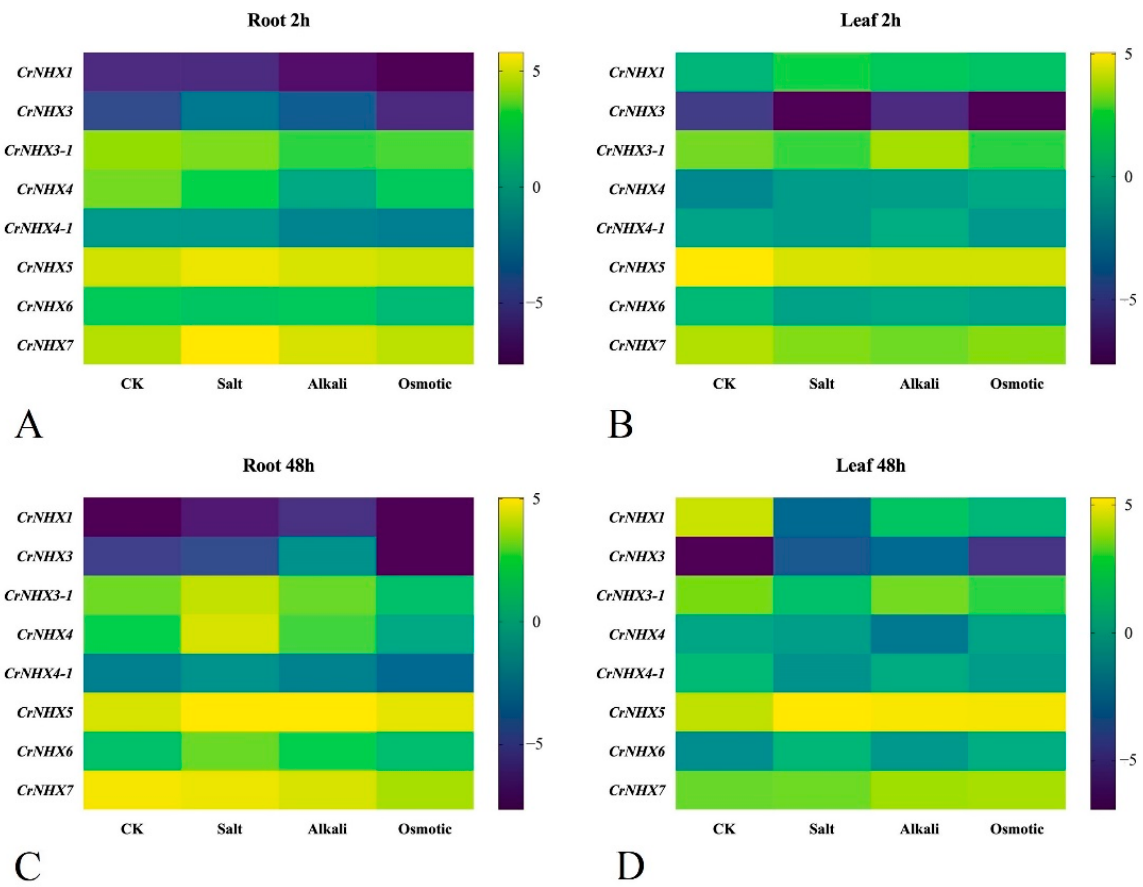
Figure 7. Heatmaps showing the expression changes of CrNHX s under high salinity, alkaline, and high osmosis stresses. ( A , B ) The expression differences of eight CrNHX s in the root ( A ) and leaf ( B ) after 2 h abiotic stress challenge; ( C , D ) the expression differences of eight CrNHX s in the root ( C ) and leaf ( D ) after 48 h abiotic stress challenge. Expression levels for each CrNHX were shown with the log2 values of FPKM. Yellow denotes high expression levels, and dark-blue denotes low expression levels.